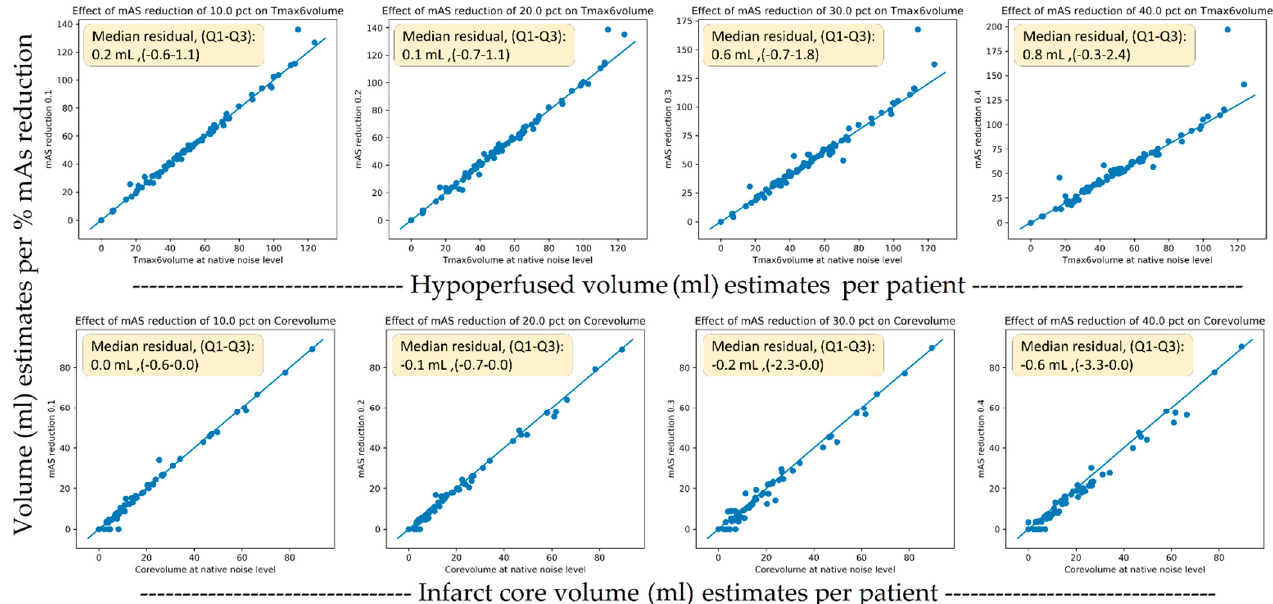
Figure 6. Scatter plots of the original versus dose reduction volumes for infarct core (lower row) and hypoperfusion (upper row) volume estimates. Table 3. Hypoperfusion and core volume differences as compared to the original acquisitions for all exposure and sampling rate reduction levels.